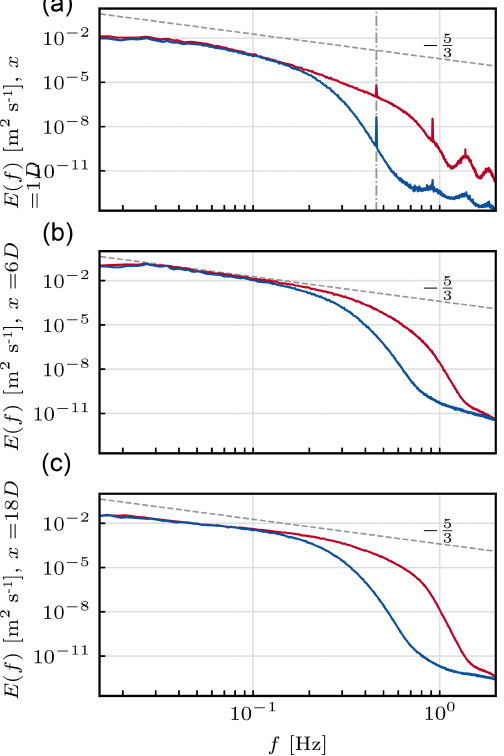
Figure 17. One-point turbulent kinetic energy spectra in the near wake ( x = 1 D , a ), transition region ( x = 6 D , b ), and far wake ( x = 18 D , c ) in turbulent inflow. Vertical dashed–dotted line marks the blade-passing frequency f B . For the legend, see Fig.